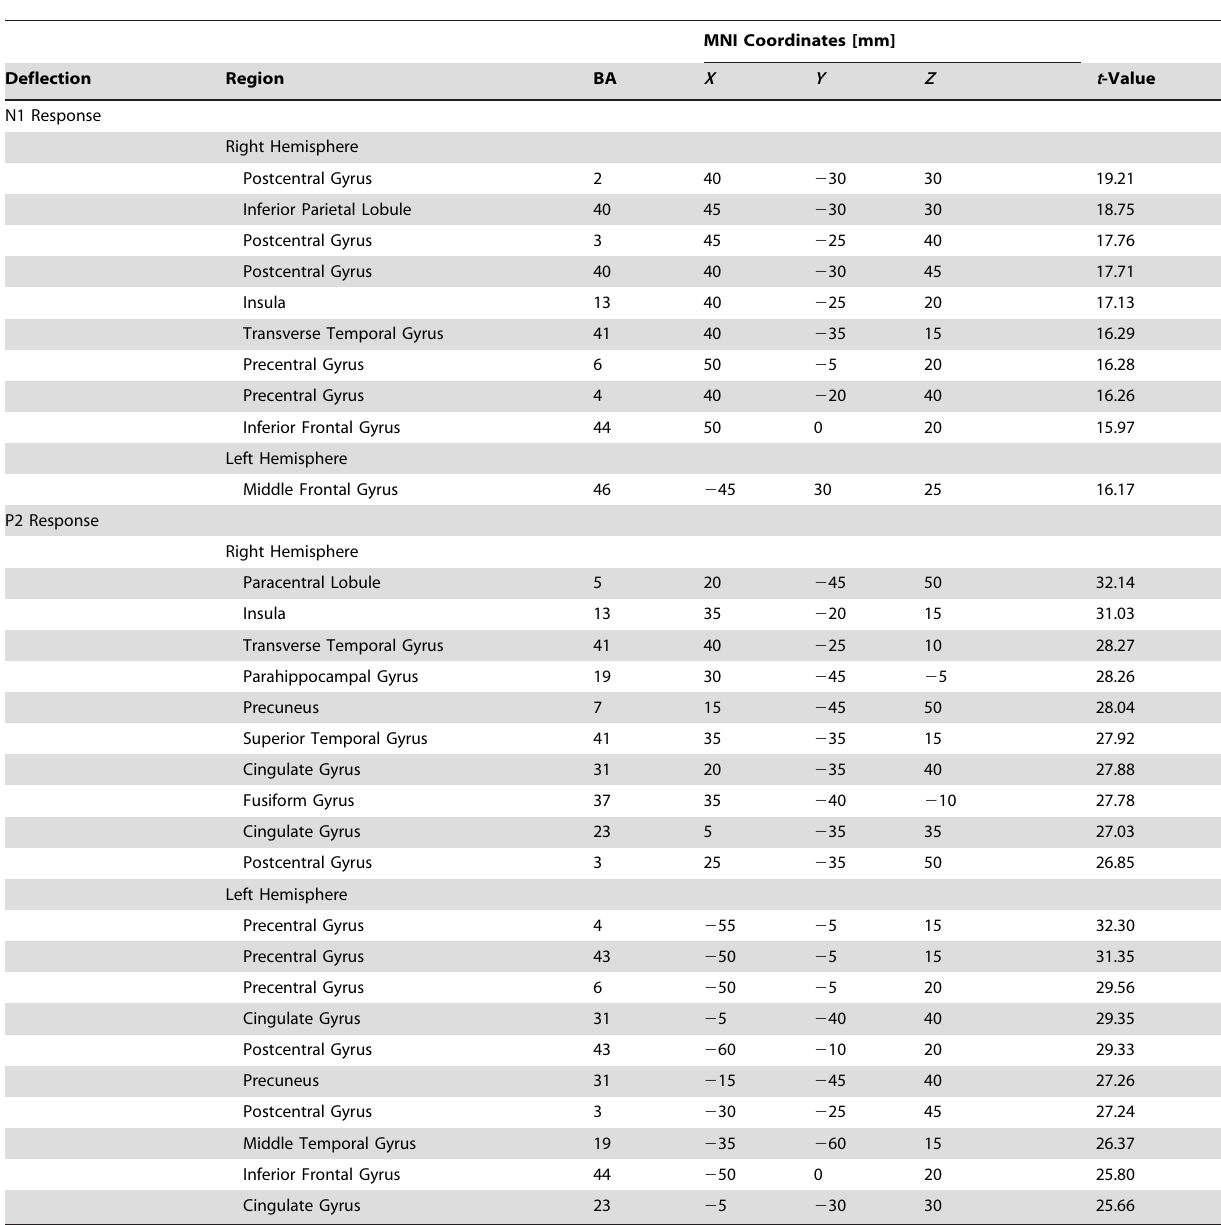
Table 2. Locations of peak t -values for N1 and P2 responses to all sound positions vs. silence as revealed by sLORETA (all p , 0.01).